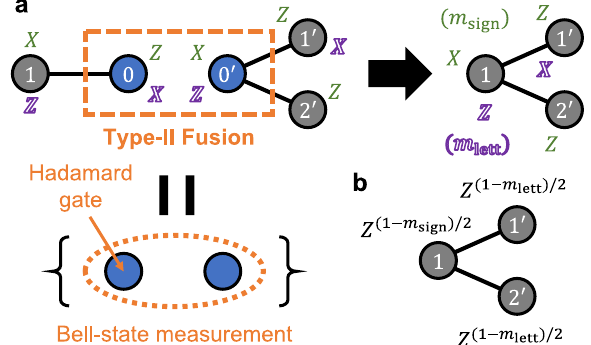
Fig. 1 Example of a type-II fusion. A type-II fusion is done by measuring Z 0 X 0 0 and X 0 Z 0 0 on the two graph states. a Two stabilizers (green and purple operators) become those of the resulting graph state up to sign factors (the sign or letter outcome m sign , m lett of the BSM) after the fusion. b The fi nal state is the depicted graph state, where the presented Pauli- Z operators are applied.